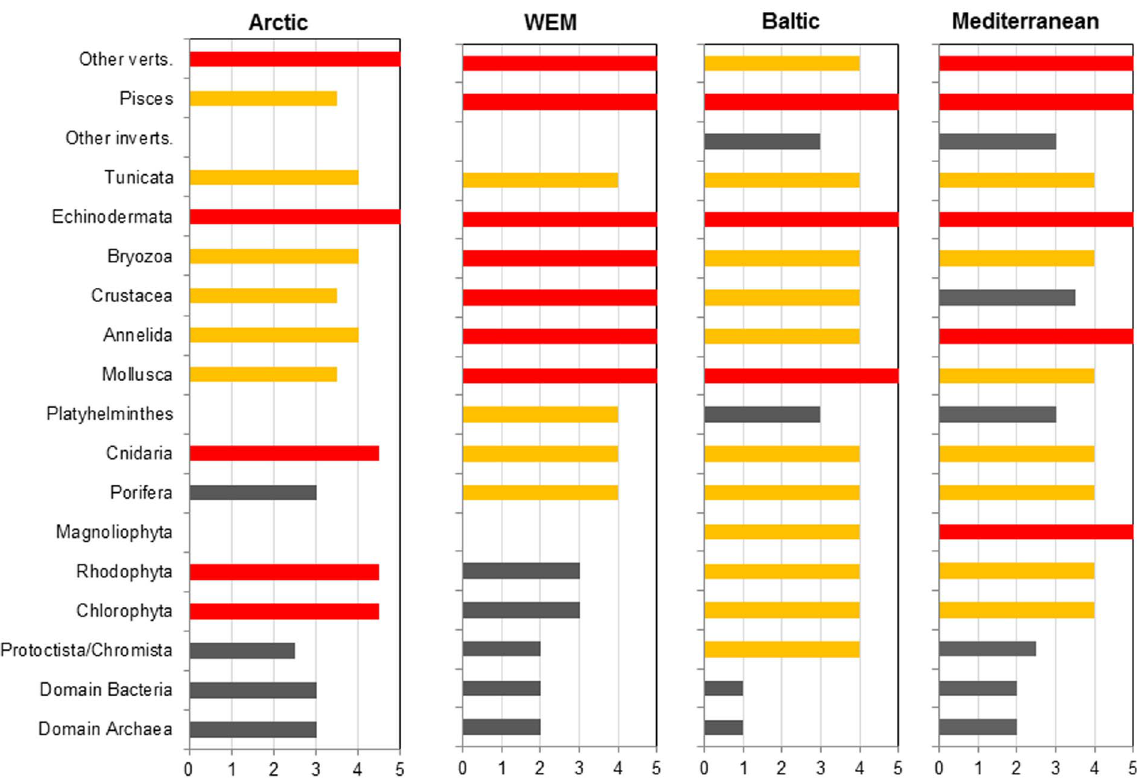
Figure 3. State of knowledge of taxonomic groups ranked from 1 – 5. Rankings equate to: 5= very well known; 4= well known; 3= poorly known; 2= very poorly known; 1= unknown (Sources: B Bluhm pers. comm; Coll et al. [9], Danovaro et al. [18], Narayanaswamy et al. [19], Ojaveer et al. [20]).